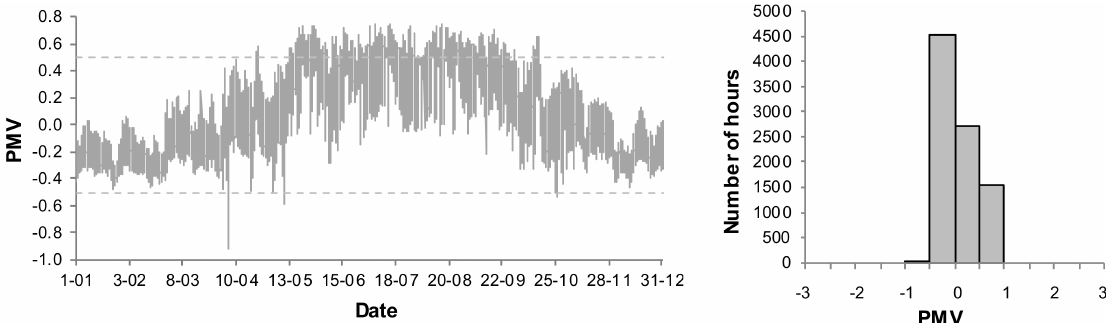
Figure 7. Annual variation and frequency distribution of (Predicited Mean Vote) PMV for living room in B2 system.